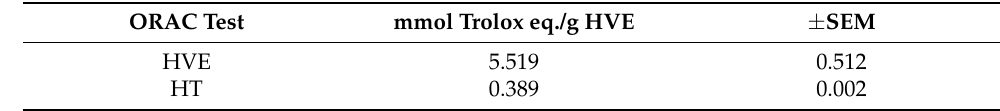
Table 2. Values of oxygen radical absorbance capacity (ORAC) of HVE and